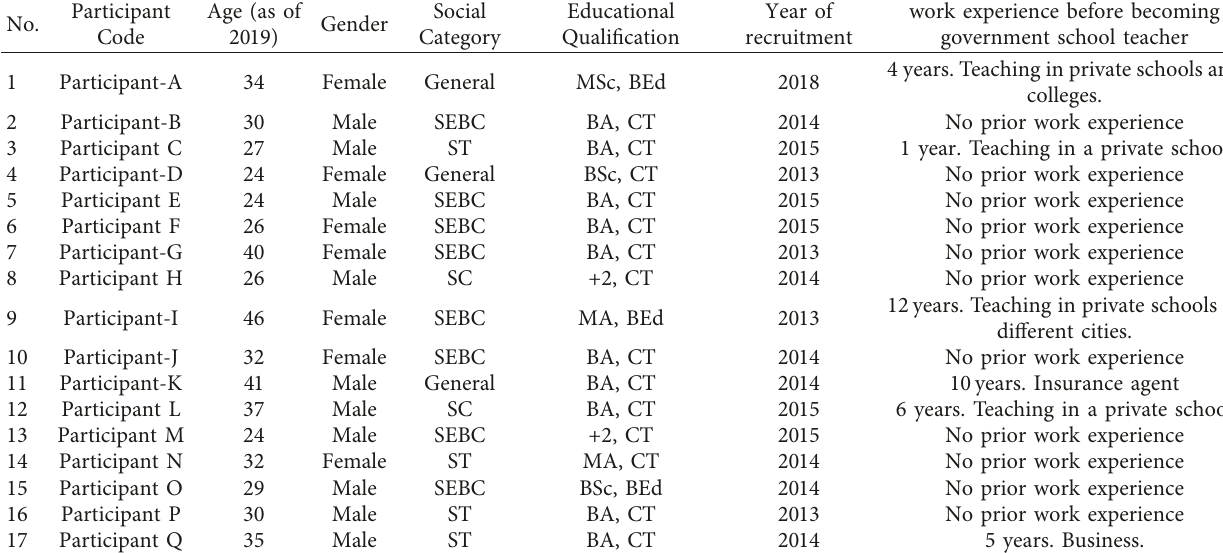
Table 1: Demographic profile of participants.